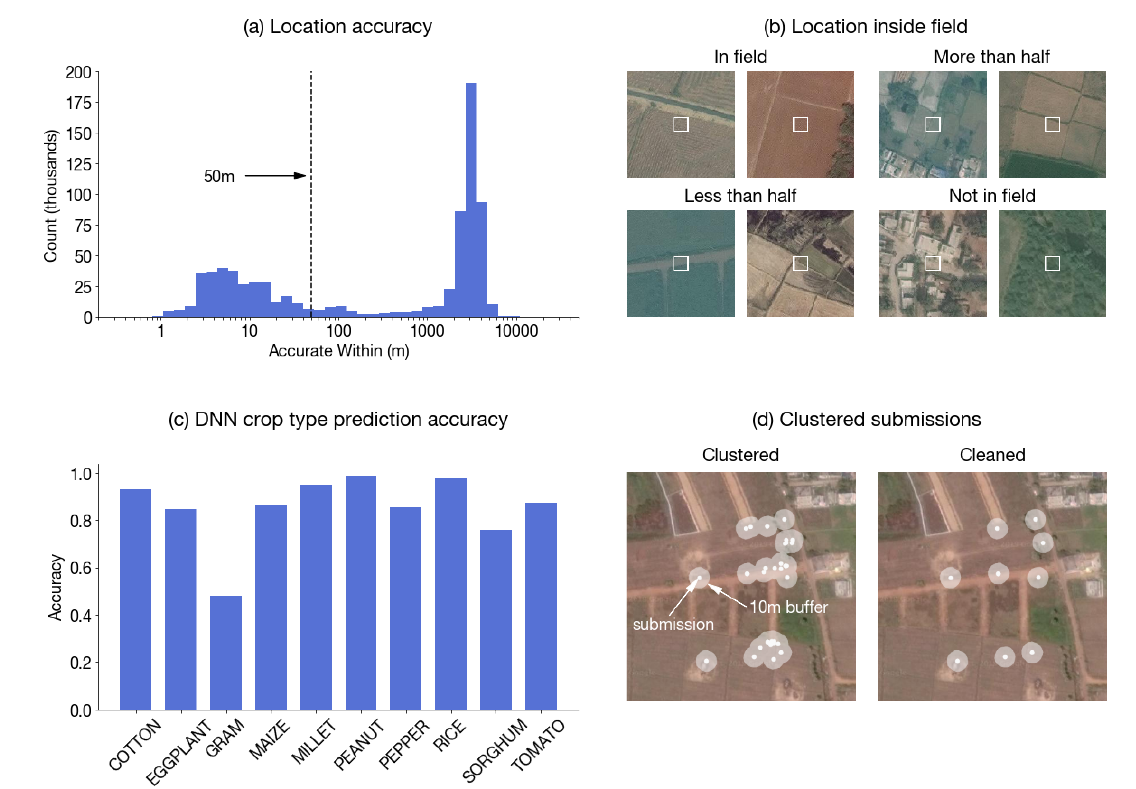
Figure 4. Sources of error in crowdsourced locations and crop type labels. ( a ) Android location accuracy varies from 1 m to 10 km depending on battery life preservation. Histogram shows accuracy distribution with 50 m as cutoff for inclusion in our analyses. ( b ) Sentinel-2 pixel (denoted by 10 × 10 m white box) may range from entirely inside to entirely not inside a crop field. ( c ) Plantix photo-based deep convolutional neural network (DNN) crop type prediction is imperfect and varies by crop type. ( d ) Clustered submissions from active locations overrepresent some geographic